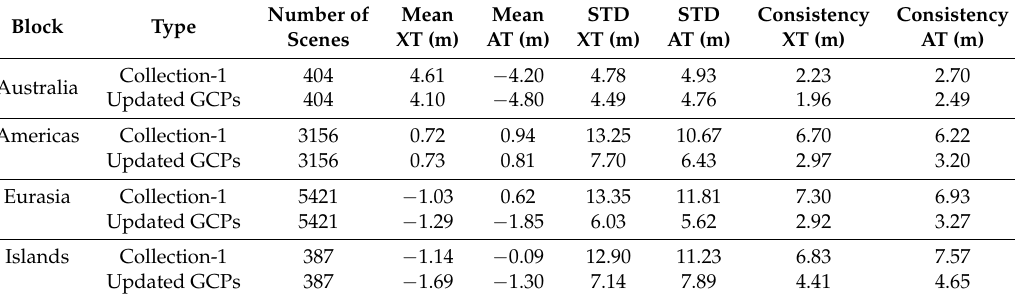
Table 7. Validation of the GCP updates using the geodetic accuracy validation procedure for all the blocks. One scene per land path/row was processed using GCPs before and after bundle adjustment for each